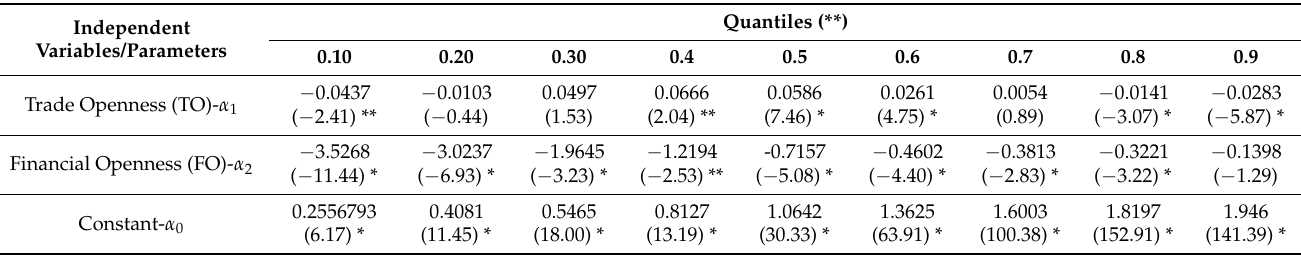
Table 4. Generalized Quantile Panel Regression Results for Government Effectiveness as GE = f (TO,